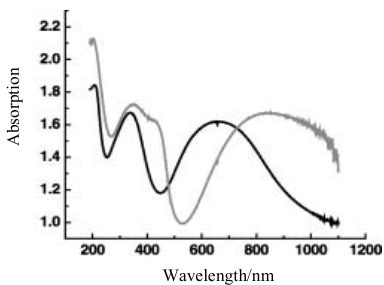
Figure 2. UV-Visible spectra of (a) undoped HPPANI (b) BF